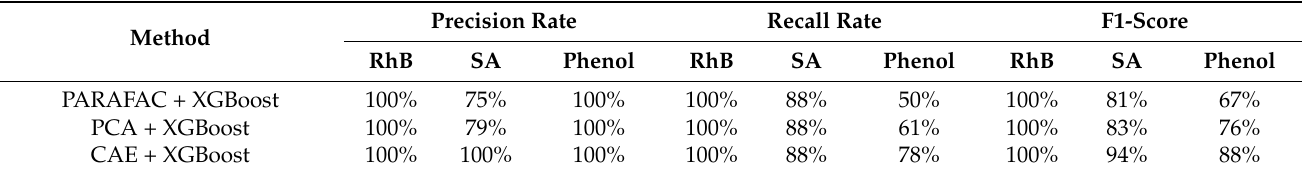
Table 2. Comparison of detection results of low concentration organic pollutants a .